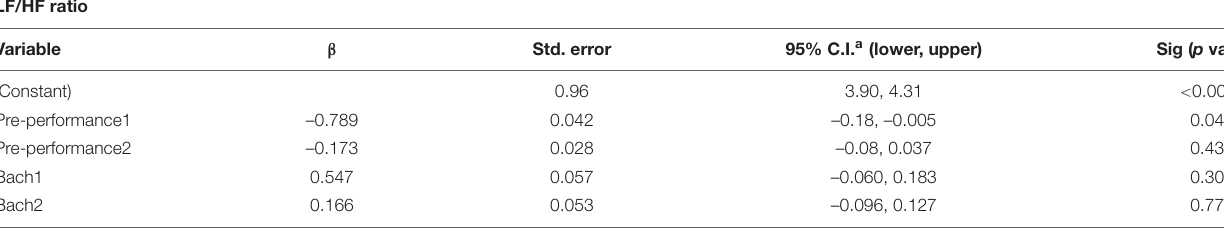
TABLE 5 | Independent associations of LF/HF ratio with flow during the Bach performance.